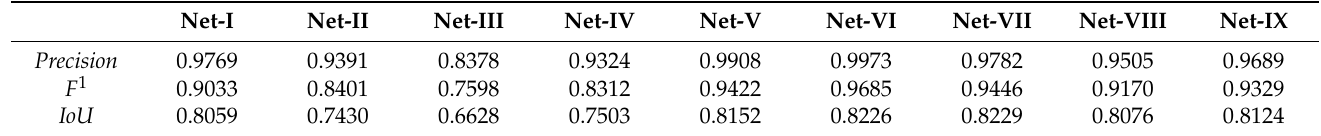
Table 17. Class metrics of cable class of testing images with the C-T ratio of 0.04.